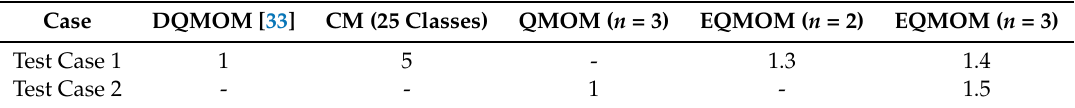
Table 16. Normalized computational costs of applied PBMs in Test Cases 1 and